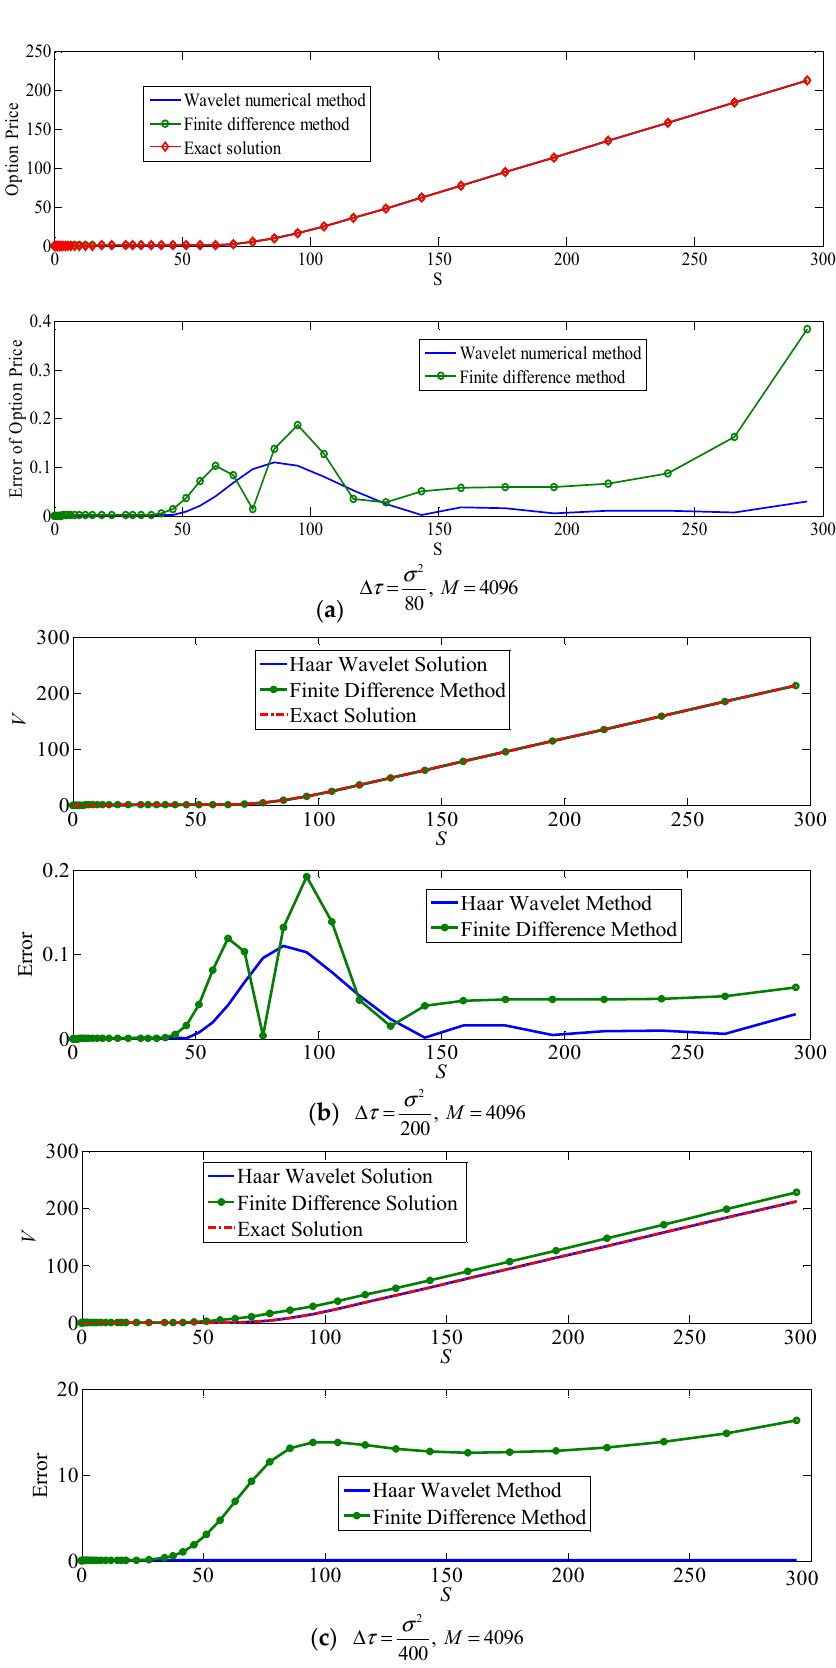
Figure 6. Comparison of the results of Haar wavelet and finite-difference algorithms.